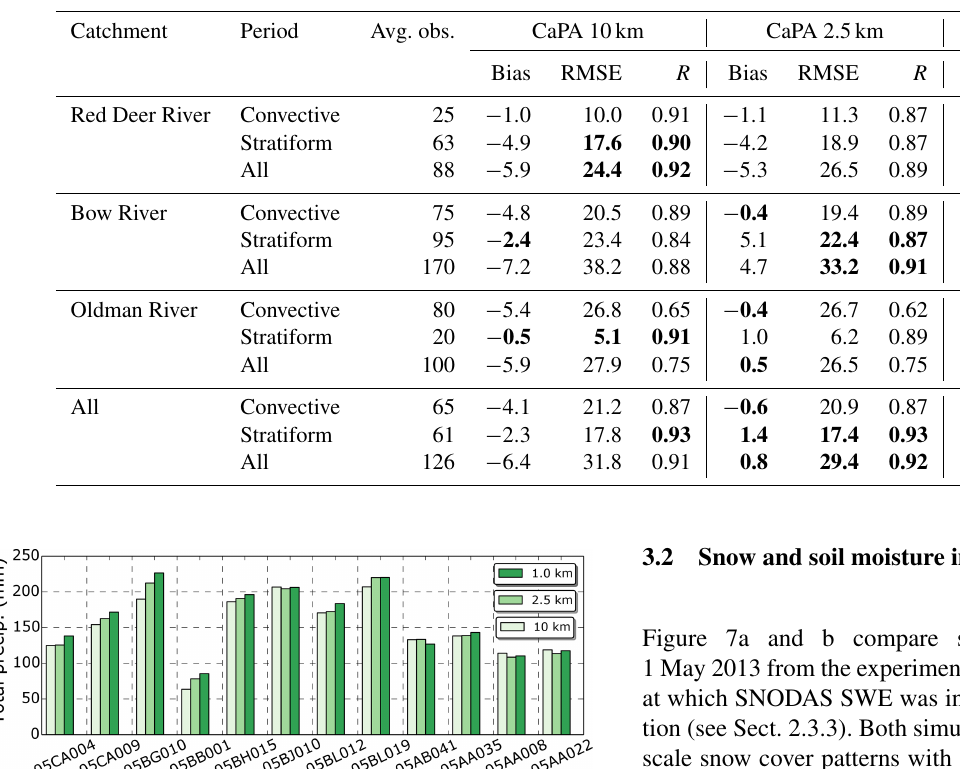
Table 5. Errors metrics (bias in mm, root mean square error – RMSE – in mm and Pearson correlation coefficient – R ) for accumulated precipitation estimated by the leave-one-out method for three CaPA experiments. Three river basins are considered as well as three time periods: a convective period (19 June at 12:00UTC to 20 June at 12:00UTC), a stratiform period (20 June at 12:00UTC to 22 June at 12:00UTC) and the whole period. Avg. obs. represents the averaged observed cumulated precipitation (in mm). Values in bold represent the best error metric among the three resolutions for each river basin and period.